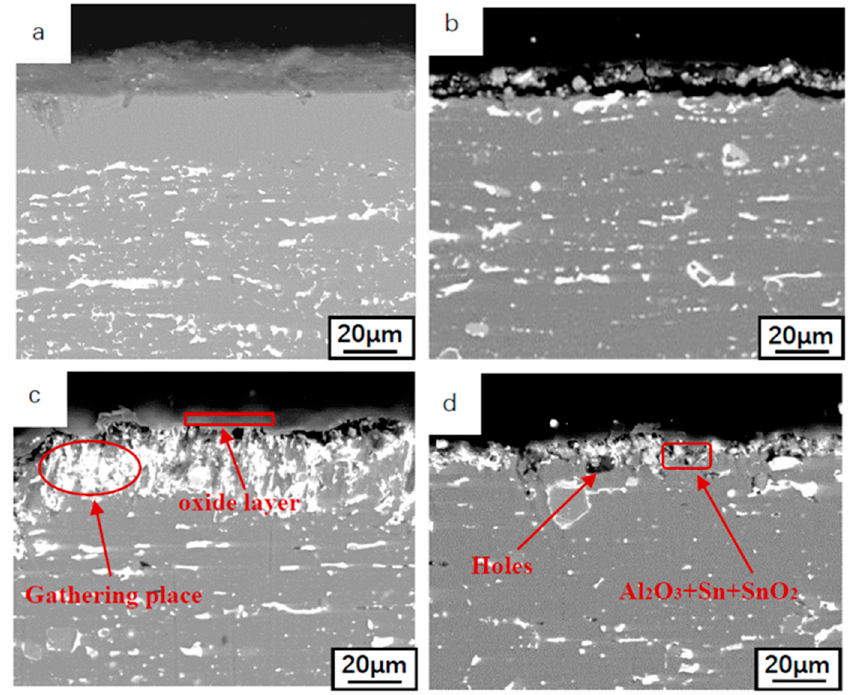
Figure 5. Cross-sectional morphologies of the oxide films at different temperatures (oxidized for 12 h) ( a ) 25 °C, ( b ) 180 °C, ( c ) 300 °C, ( d ) 500 °C.